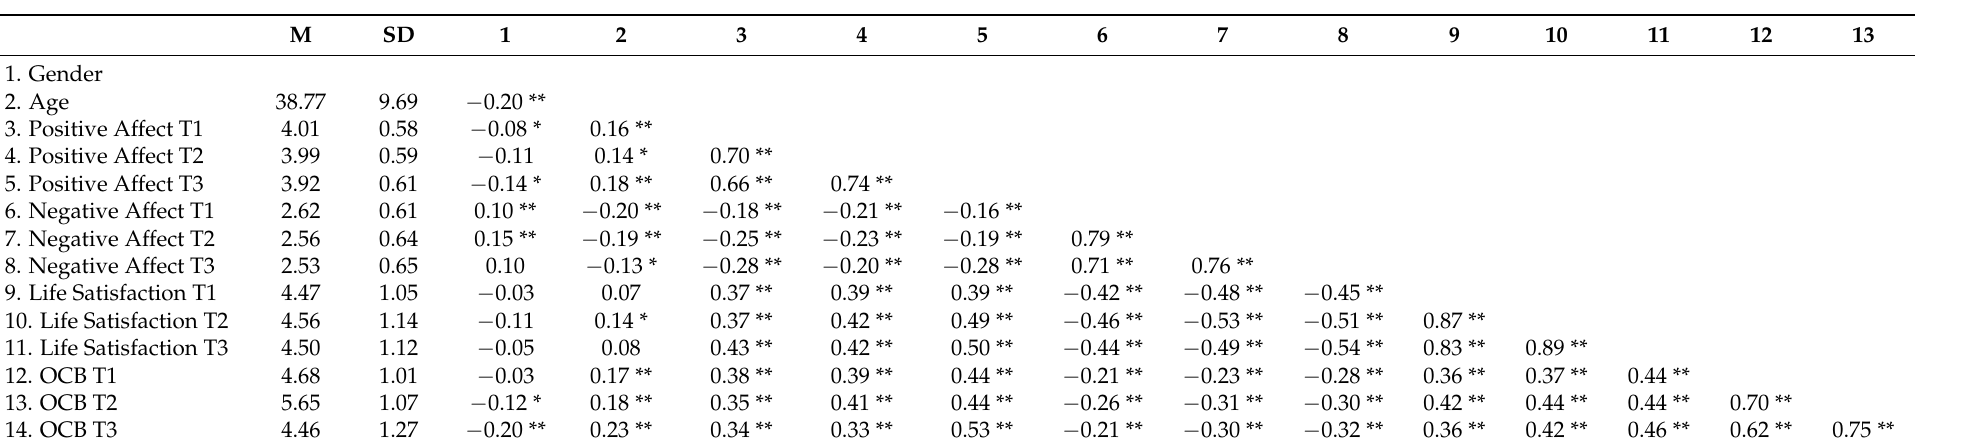
Table 2. Descriptive and inter-correlations for Model 1